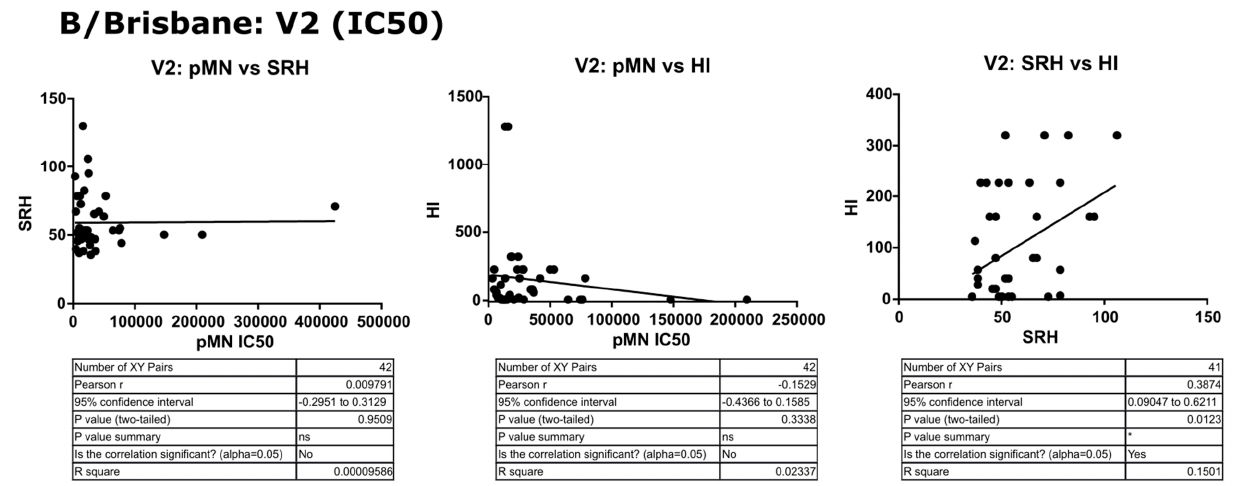
Figure 6. Correlation of SRH, HI and pMN (IC 50 ) mean V2 values assayed against B/Brisbane/60/2008 PV. Pearson’s two-tailed analysis performed using GraphPad Prism. No correlation was observed between IC 50 antibody titres and SRH or HI (Pearsons r = 0.009 and -0.152, respectively). SRH and HI values were correlated (Pearsons r = 0.38). p > 0.05 = ns, p ≤ 0.05 = *.